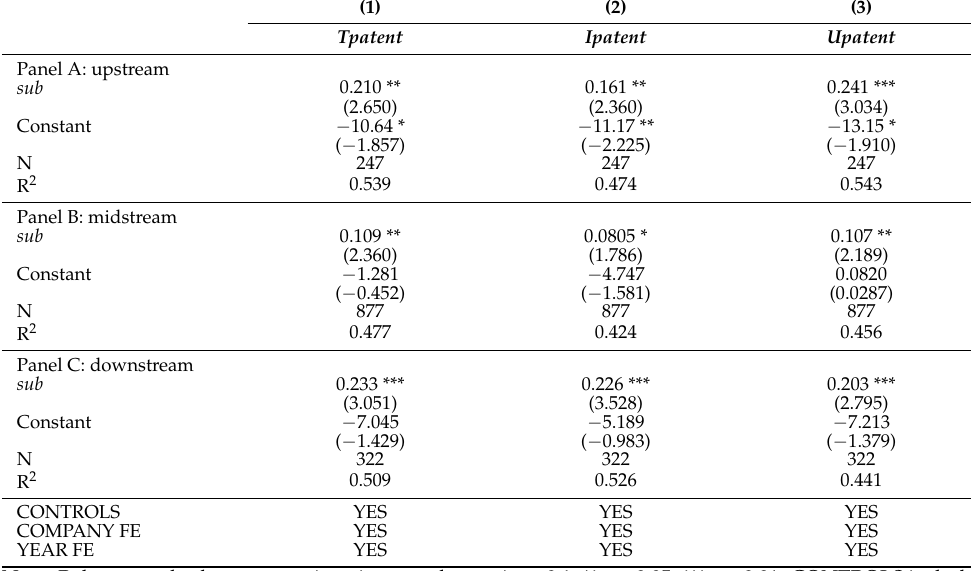
Table 11. Heterogeneity analysis: Industrial chain perspective (quantity of technological innovation).